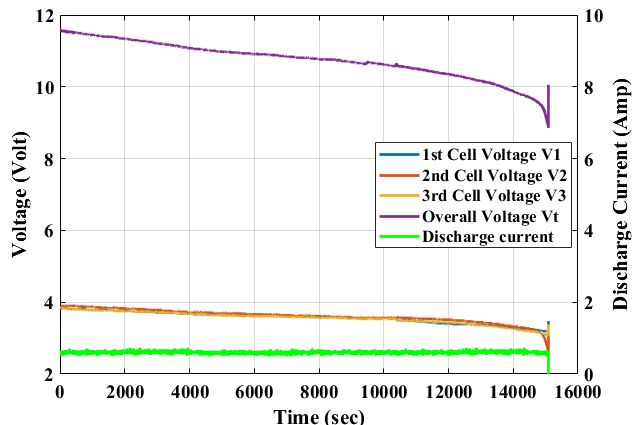
Figure 15. Discharging curve at 0.23 C.